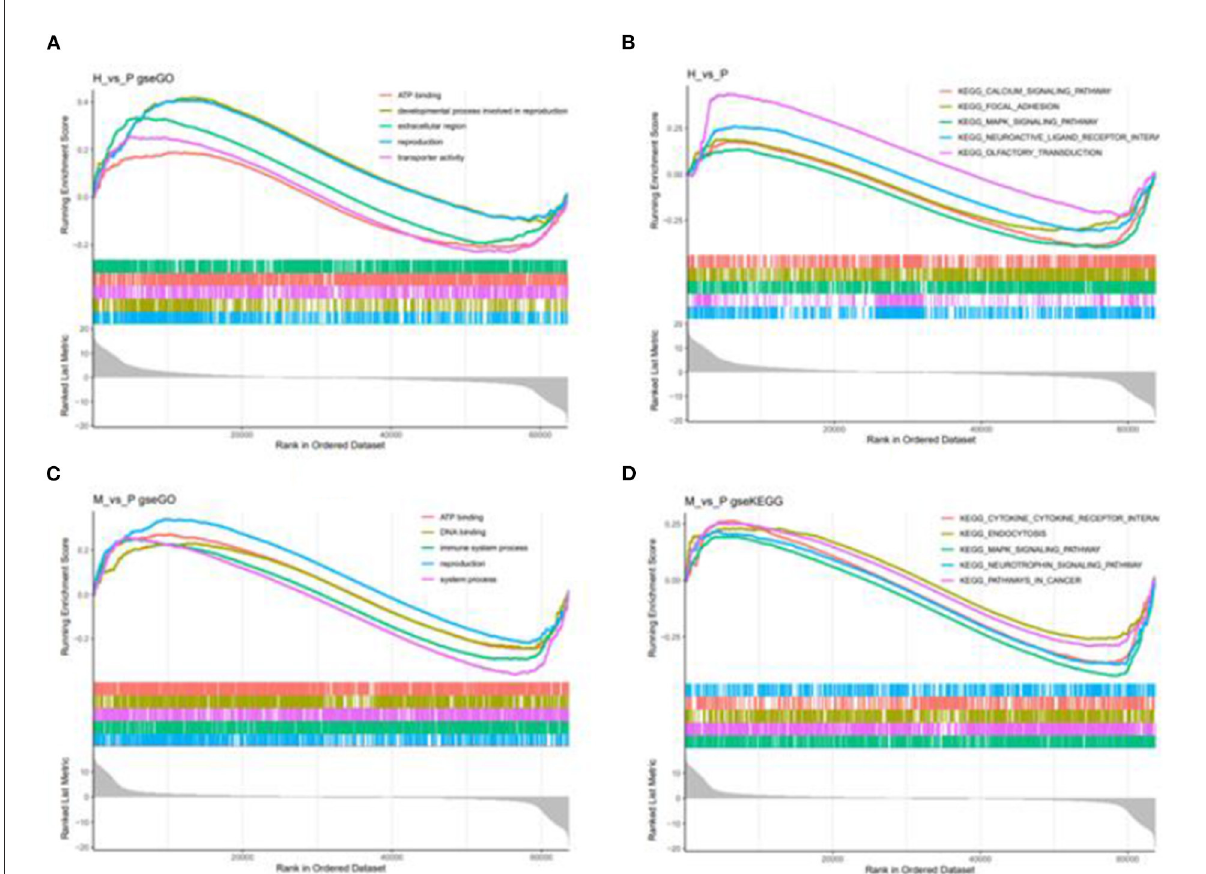
FIGURE9 GSEA enrichment plot of differentially expressed genes in H vs. P and M vs. P. (A) The first five go terms of DEG in the GSEA-GO analysis of H vs. P. (B) The first five KEGG pathways of EDG in the GSE-KEGG analysis of H vs. P. (C) The first five go terms of DEG in the GSE-GO analysis of M vs. P. (D) The first five KEGG pathways of EDG in the GSEA-KEGG analysis of M vs. P. One curve for each color represents each term or